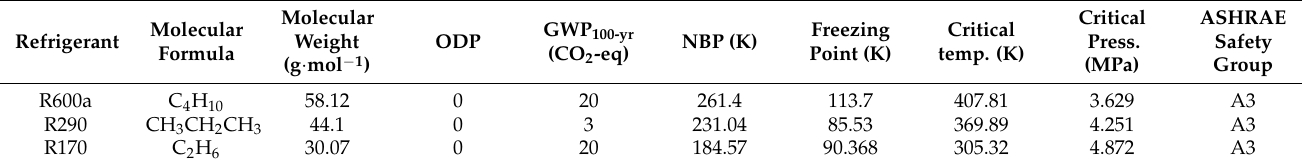
Table 1. Physical properties of refrigerants [25,31].